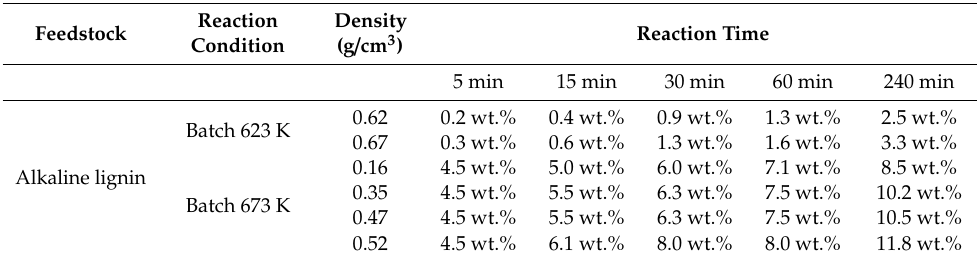
Table 7. The phenol yield with di ff erent water densities and reaction times at 623 K and 673 K. Data taken from Wahyudiono et al. [95]. Reaction Feedstock